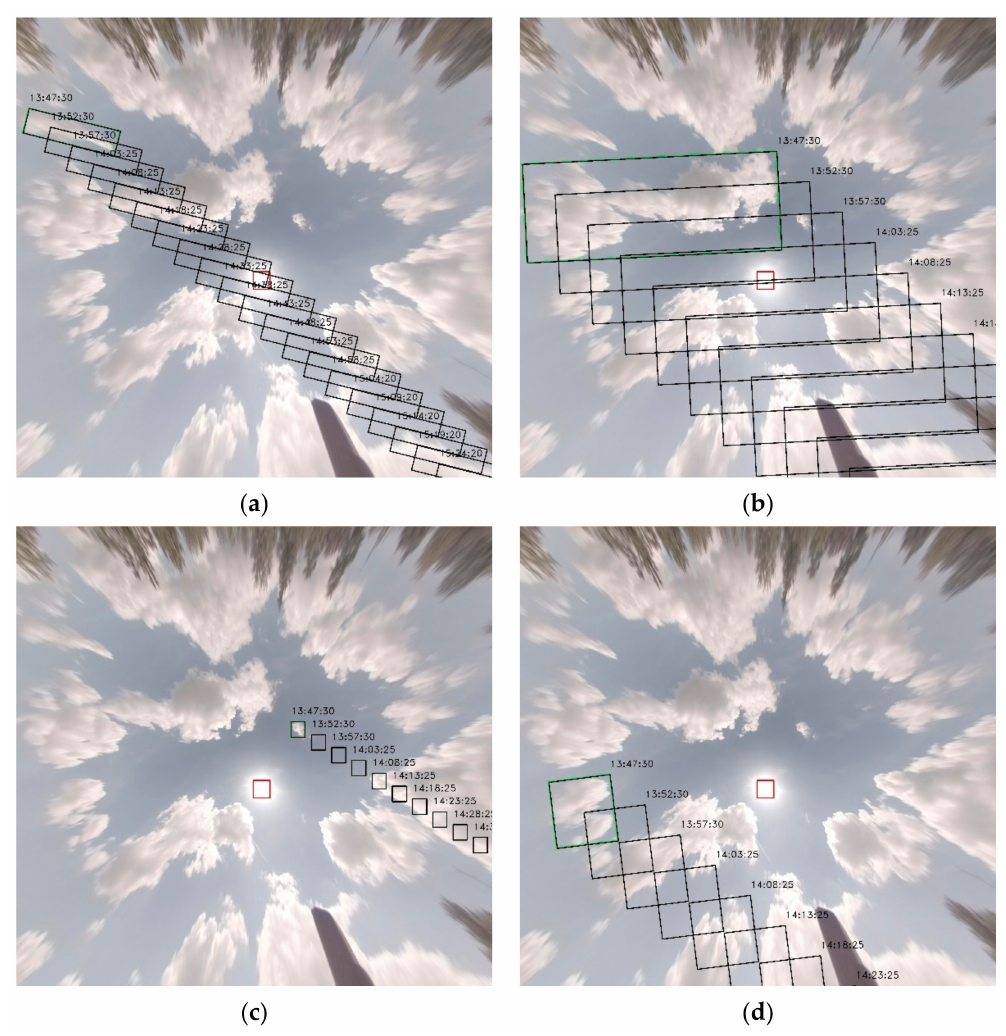
Figure 11. Estimated positions of the clouds based on the movement simulation: ( a ) for the cloud that entered the image and has the lowest speed, ( b ) for the biggest cloud that is tracked, ( c ) for the smallest cloud that is tracked, ( d ) for the cloud with the highest